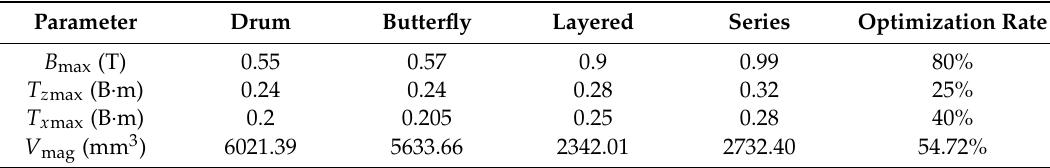
Table 1. Improving the main parameters of motor.